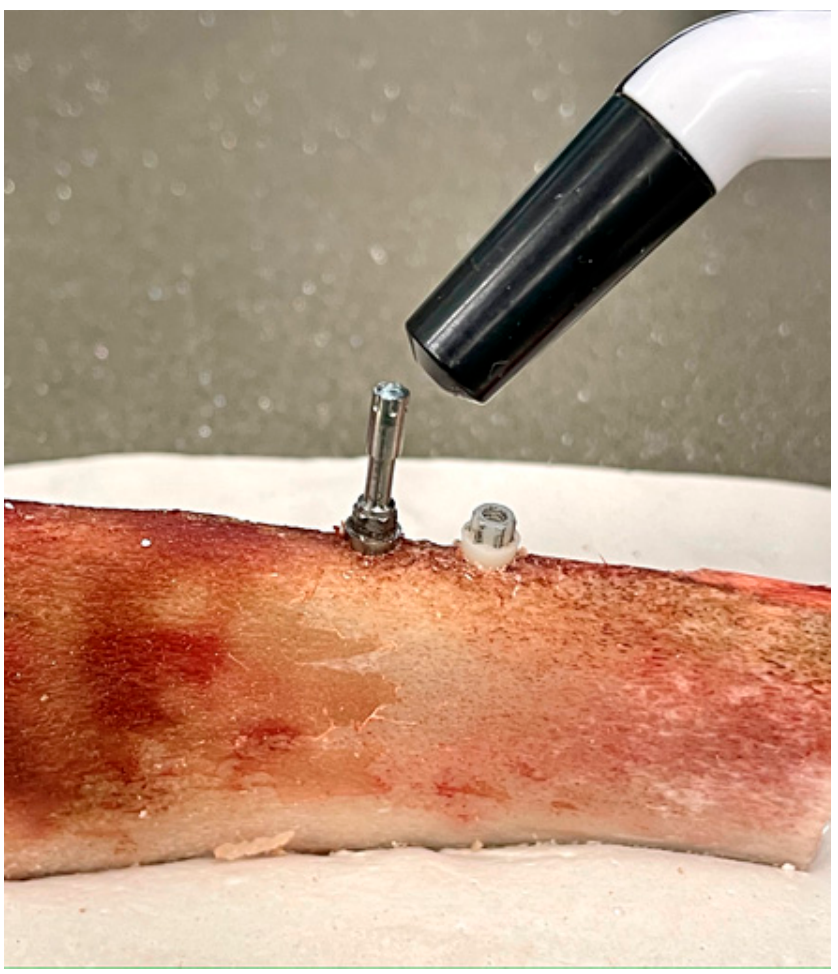
Figure 3. Measurement of implant stability by resonance frequency analysis using a Penguin and its Multipeg transducer screwed to the TI implant, expressed in ISQ values. On the right, the Zr implant placed in the same rib can be seen .